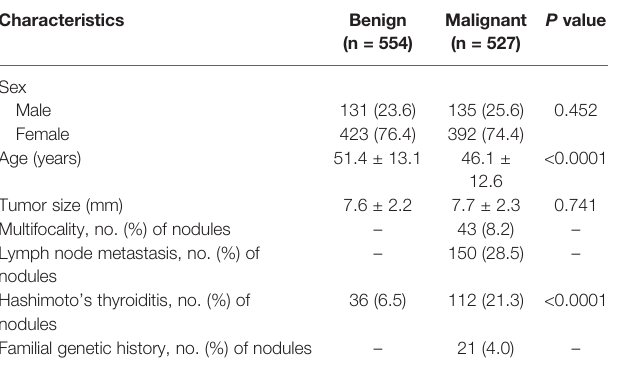
TABLE 1 | Demographic and clinicopathologic characteristics of the study population.